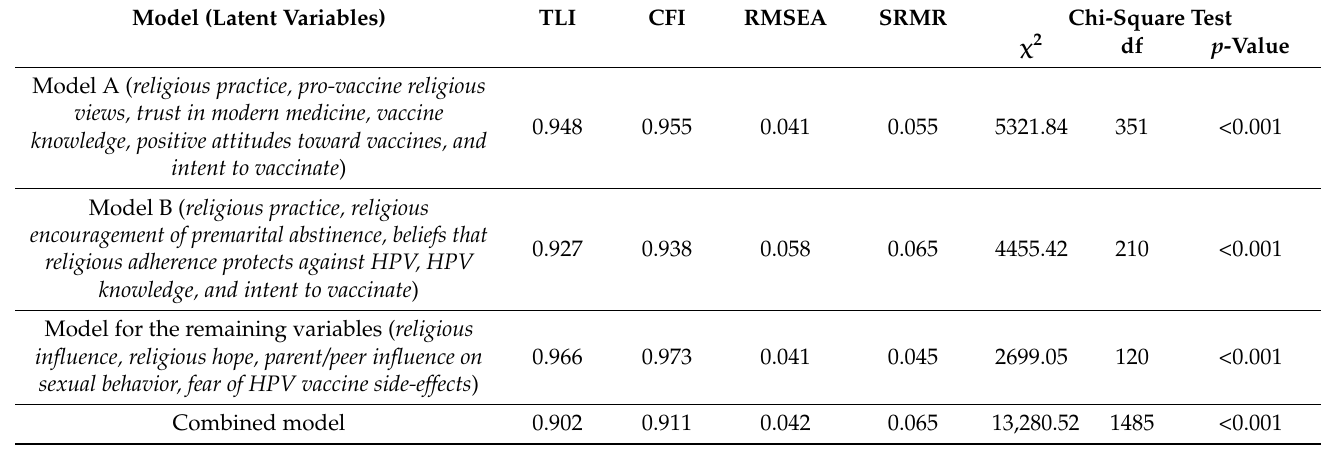
Figure 1. Hypothetical models, illustrating components of hypotheses. ( A ) We hypothesize that religious practice and pro-vaccine religious views influence trust in modern medicine, vaccine knowledge, and general positive attitudes toward vaccines, which, in turn, influence intent to vaccinate children against HPV. ( B ) We hypothesize that religious practice and encouragement of premarital abstinence influence beliefs that religious adherence protects against HPV and knowledge about HPV, which, in turn, influence intent to vaccinate. These connections are illustrated visually in the models. Table 2. Fit statistics for each measurement model.